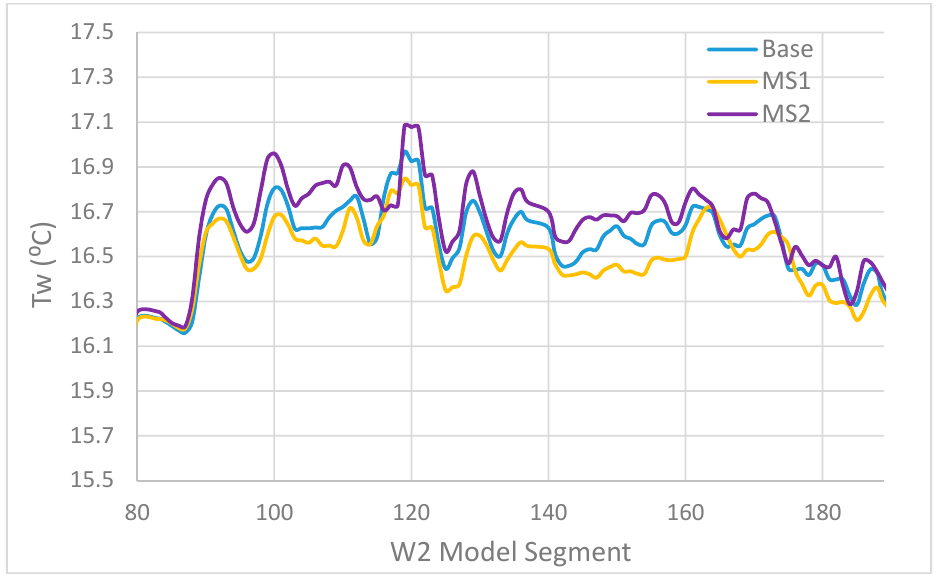
Figure 9. Longitudinal profile of T w in the Tigris River from Baghdad to Kut Barrage at JDAY